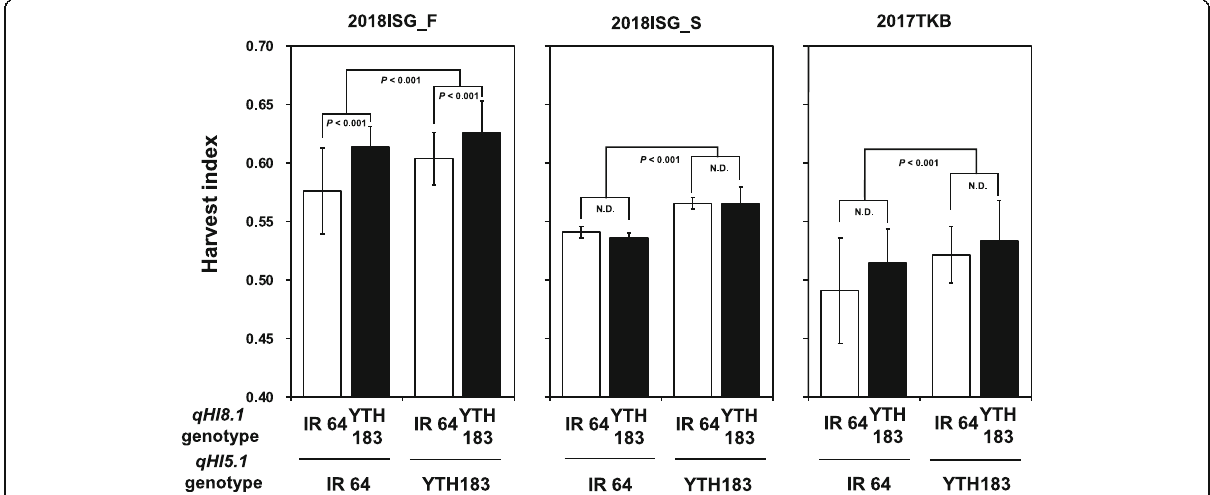
Fig. 4 The mean of harvest index in 2018ISG_F, 2018ISG_S, and 2017TKB for different genotype classes between qHI5.1 and qHI8.1 in RIL populations. Genotypes are represented by the nearest marker loci, RM1089 ( qHI5.1 ) and 8,099,836 ( qHI8.1 ). The P value indicates the statistical analysis by Student ’ s t-test. N.D. indicates no significant